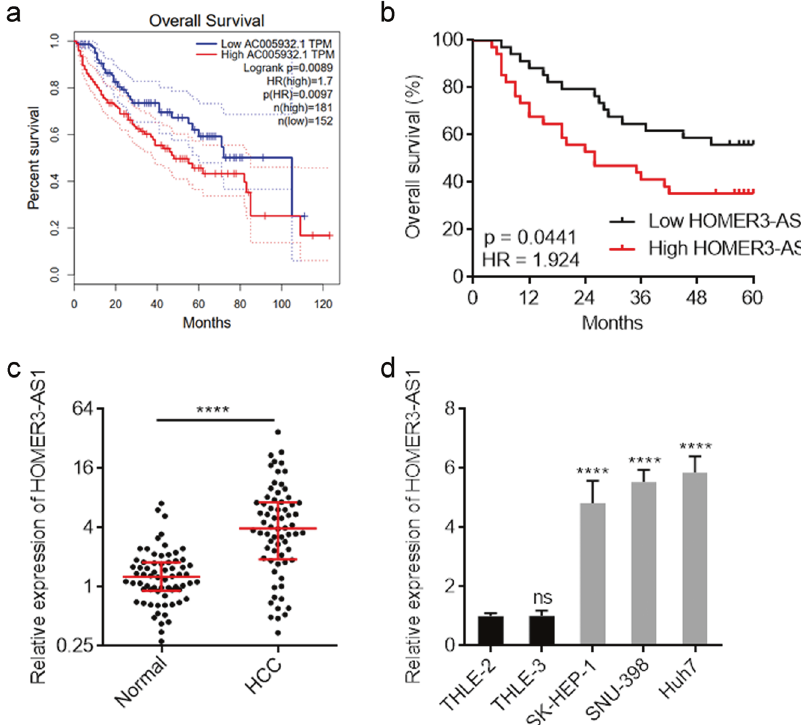
Fig. 1 The expression and clinical relevance of HOMER3-AS1 in HCC. a The correlation between HOMER3-AS1 (AC005932.1) expression and overall survival according to TCGA LIHC dataset, analyzed by GEPIA. b Kaplan-Meier survival analysis of the correlation between HOMER3-AS1 expression and overall survival in our HCC cohort. n = 68, p = 0.0441, HR = 1.924 by log-rank test. c HOMER3-AS1 expression in 68 pairs of HCC tissues and adjacent noncancerous liver tissues was measured by qRT-PCR. **** p < 0.0001 by Wilcoxon matched-pairs signed-rank test. d HOMER3-AS1 expression in immortalized human liver cell lines THLE-2 and THLE-3, and human HCC cell lines SK-HEP-1, SNU-398, and Huh7 were measured by qRT-PCR. Results are presented as mean ± SD based on three independent experiments. **** p < 0.0001, ns, not signi fi cant, by one-way ANOVA followed by Dunnett ’ s multiple comparisons